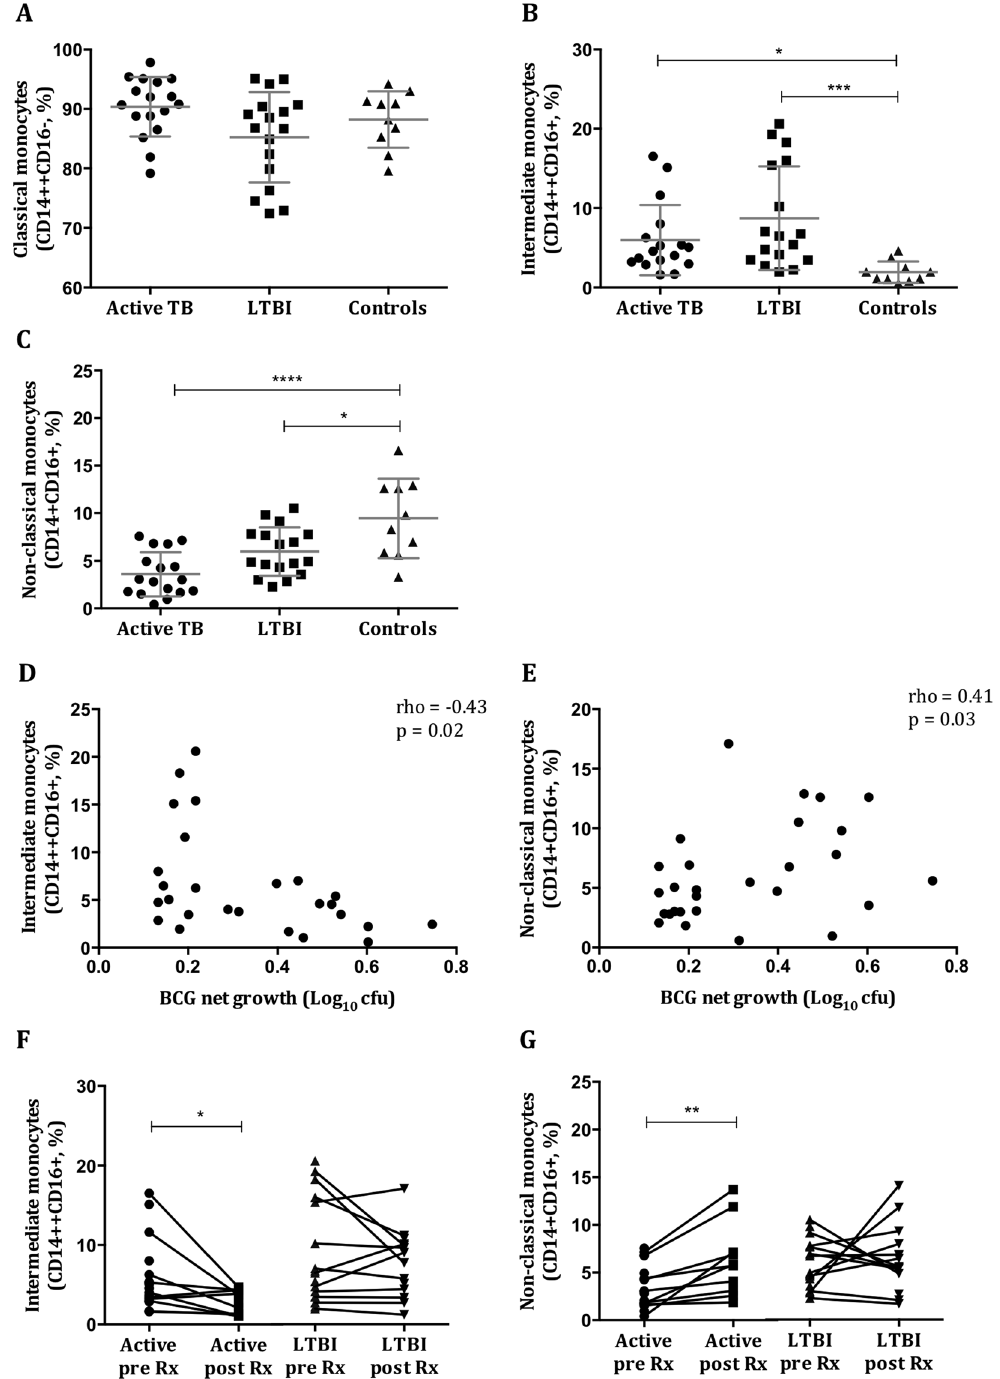
Figure 3. Altered proportions of intermediate and non-classical monocyte subsets are associated with differential mycobacterial control. Monocyte subsets were characterized among patients with active TB disease (n = 17), LTBI (n = 17) and healthy controls (n = 10) before starting anti-TB treatment. The proportions of classical ( A ), intermediate ( B ), and non-classical ( C ) monocytes were calculated from the total monocyte population. A negative correlation between intermediate monocytes and net growth ( D ), and a positive correlation between non-classical monocytes and net growth ( E ) of BCG were seen. The latter was also seen with M . tb H37Rv (data not shown). Monocyte subsets were then characterized after completion of treatment among active TB (n = 11) and LTBI (n = 14) patients. The proportions of intermediate ( F ) and non-classical ( G ) monocytes are shown. Points are single values and bars represent the mean with SD. After testing for normality, an ordinary one-way ANOVA with Tukey’s correction ( A , C , G ) or a Kruskal-Wallis test with Dunn’s correction for multiple comparisons ( B , F ) was performed. * Represents a p-value of < 0.05, ** a p-value of < 0.005, *** a p-value of < 0.0005 and **** a p-value of < 0.0001. For correlations Spearman’s rho and associated p-values are